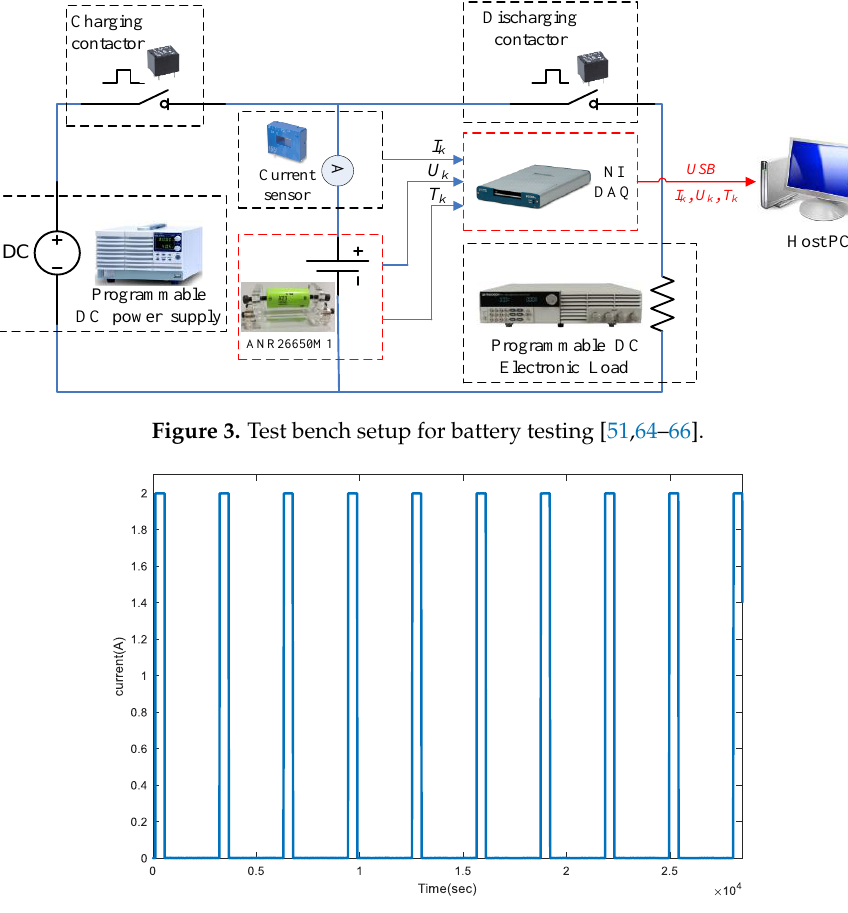
Figure 4. Discharge current pulses during discharging pulse test.